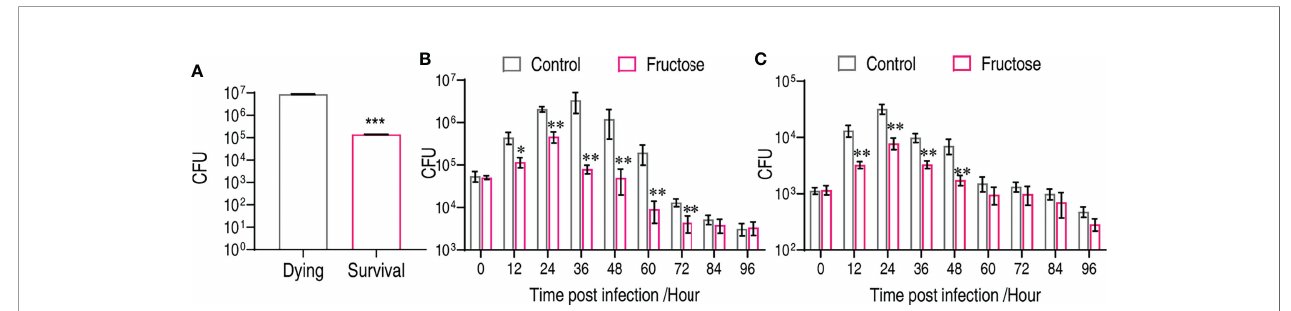
FIGURE 6 | Fructose reduce bacterial load in vivo . (A) CFU counts in dying (n = 15) and survival (n = 15) liver of crucian carp. (B) Time-dependent CFU count in the liver of crucian carp that were treated with fructose (100 m g) for 3 days and infect with lethality dose of bacteria. Scatter plot represents mean ± SEM of 6 biological replicates, signi fi cance was analyzed by Mann – Whitney U-test, *p < 0.05, **p < 0.01, ***p < 0.001. (C) Dynamic change of crucian carp liver bacterial number after being treated with or without fructose (100 m g) for 3 days and infected with a non-lethal dose of bacteria. Scatter plot represents mean ± SEM of 6 biological replicates; signi fi cance was analyzed by the Mann – Whitney U-test, **p < 0.01, ***p < 0.001.